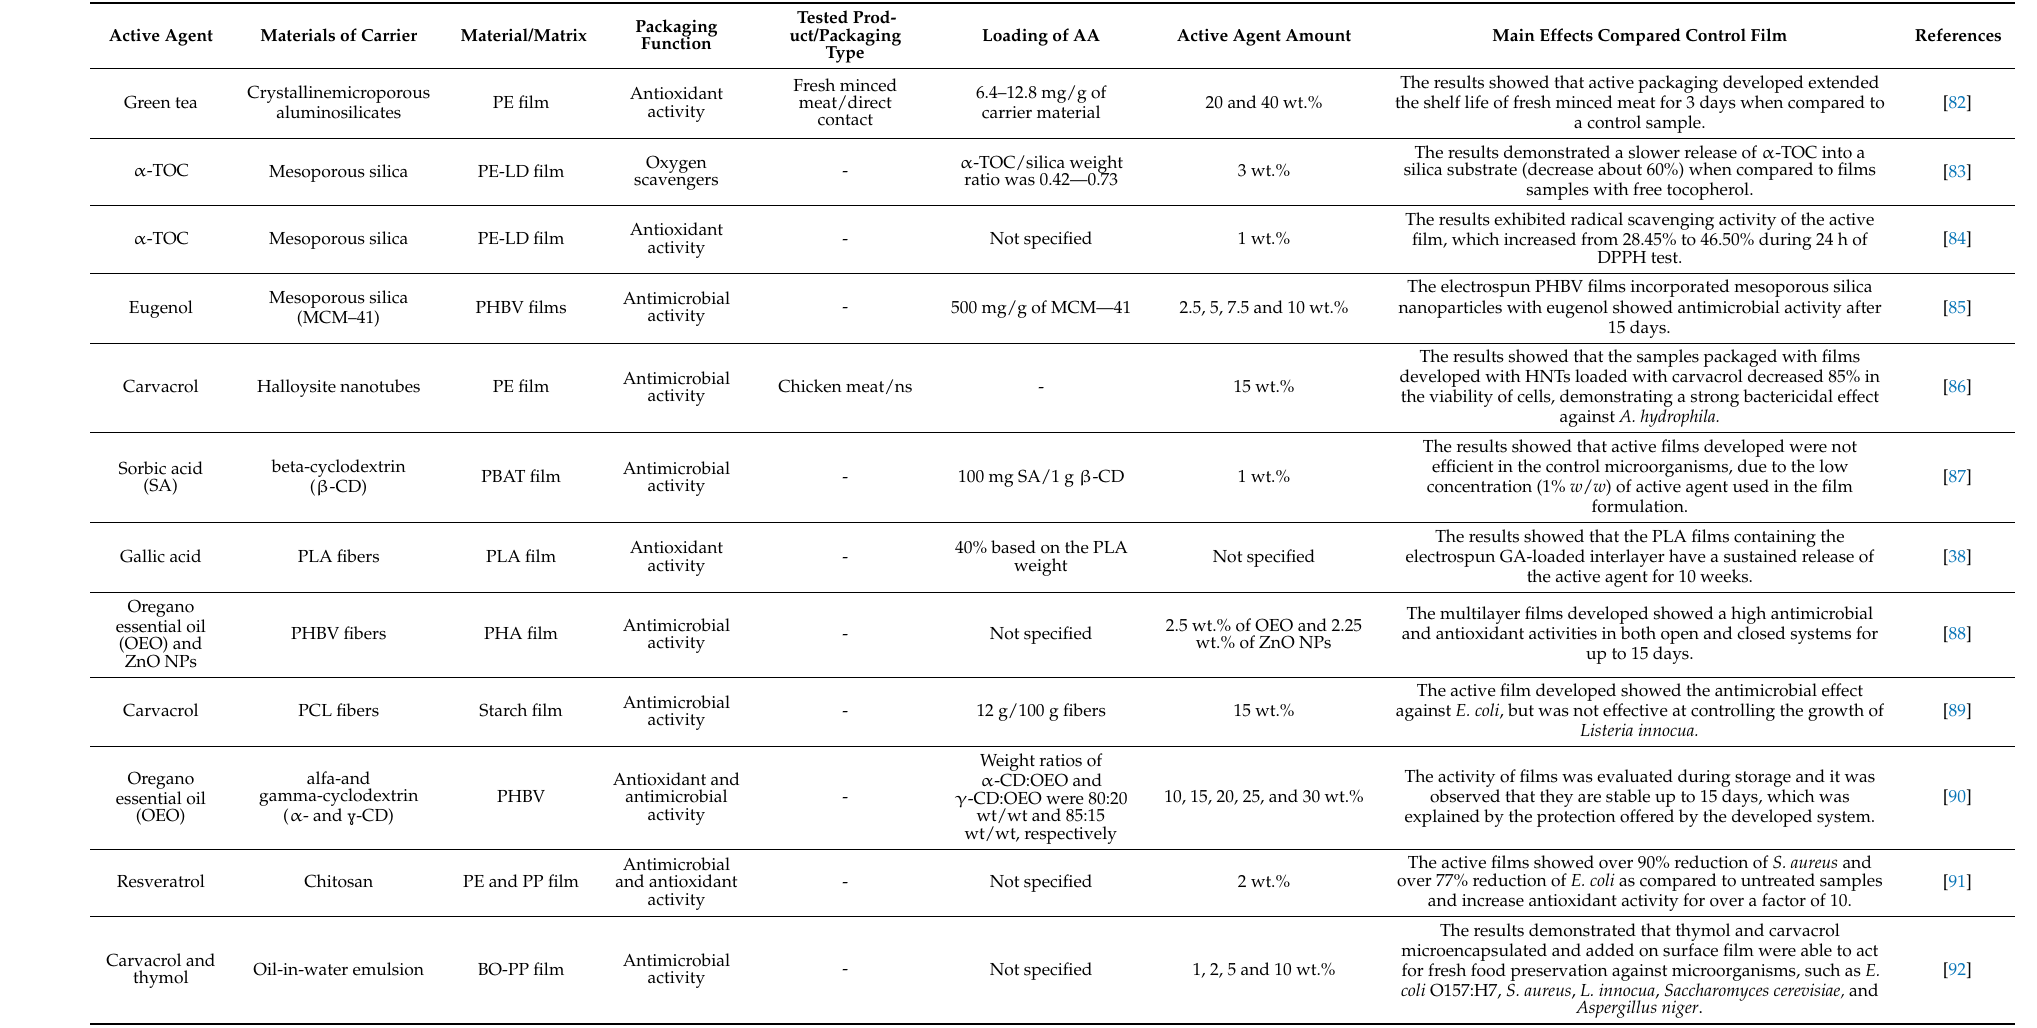
Table 5. Applications of carriers of the active agents added into flexible